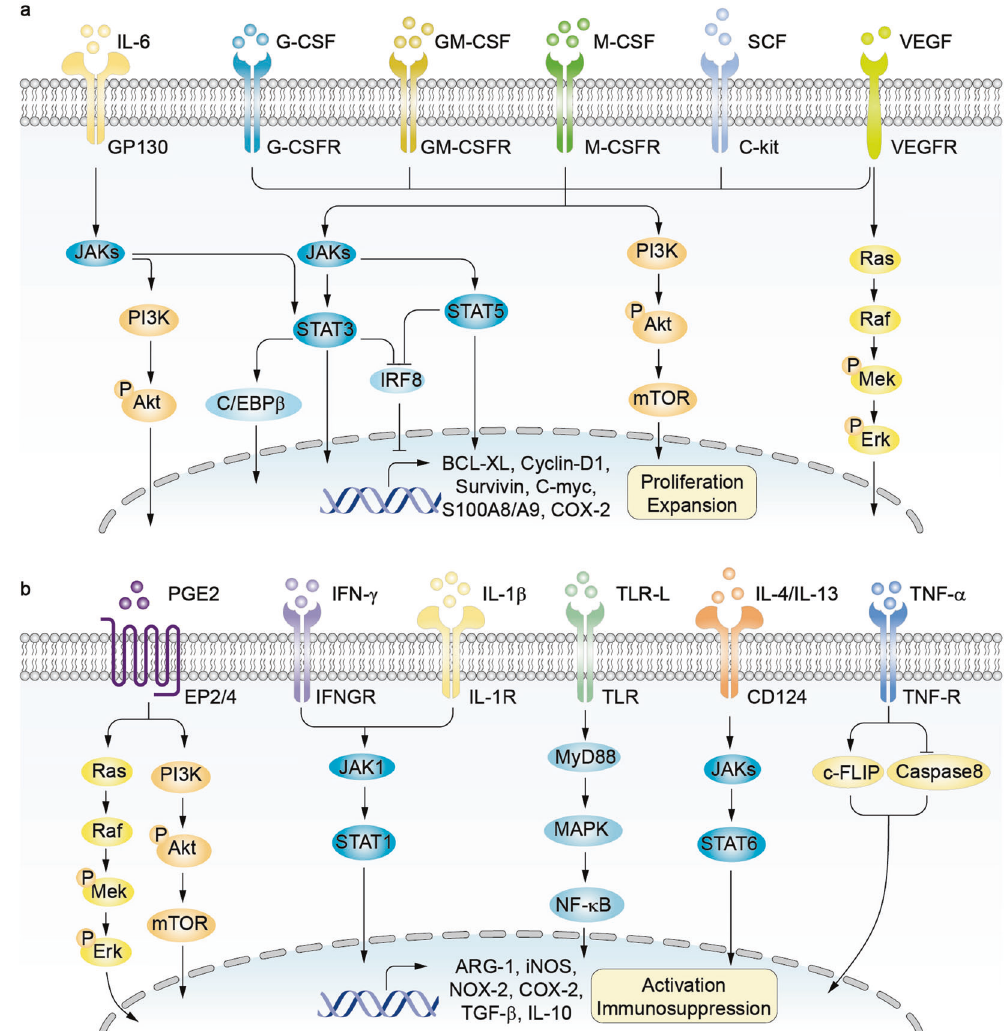
Fig. 3 Signaling pathways of MDSCs expansion and activation. a CSFs, SCF, IL-6 and VEGF are key promoters of MDSCs proliferation and expansion. The process is regulated by JAKs-STATs, PI3K-Akt, and Mek-Erk signaling pathways, leading to the expression of BCL-XL, Cyclin-D1, and C-myc in MDSCs. MDSCs expansion is inhibited by interferon-related factor 8 (IRF-8). G-CSF and GM-CSF downregulate IRF-8 expression through modulation of STAT3 and STAT5, respectively. b Numerous cancer-associated factors mediate the activation and immunoregulatory function of MDSCs. PGE2 activates EP2/4 signaling through Mek-Erk and PI3K-Akt pathways. IFN- γ and IL-1 β activate MDSCs through JAK1- STAT1 pathway. Proin fl ammatory danger signals such as S100A8/A9 proteins and high-mobility grow box-1 (HMGB1) enhance MDSCs traf fi cking and function by binding to TLRs. IL-4 and IL-13 function through IL-4R α -dependent STAT6 activation. TNF- α activates TNF-R signaling by upregulating cellular FLICE-inhibitory protein (c-FLIP) expression and by suppressing caspase-8 activity. All these signals can induce the expression of inhibitory factors such as ARG-1, iNOS, NOX-2, COX-2, TGF- β , and IL-10 in PMN-MDSCs in colorectal tumors. 48 On the other hand, in fi ltration of newly formed MDSCs to tumor sites are recruited by tumor- associated C – C and C – X – C motif chemokines and their recep- tors. 49 These chemokines are not unique for speci fi c cancer types and have high redundancy to sustain the constant migration of MDSCs. The CCL2/CCR2 axis is the main pathway implicated in monocytes/M-MDSCs migration, 50 while neutrophils/PMN-MDSCs